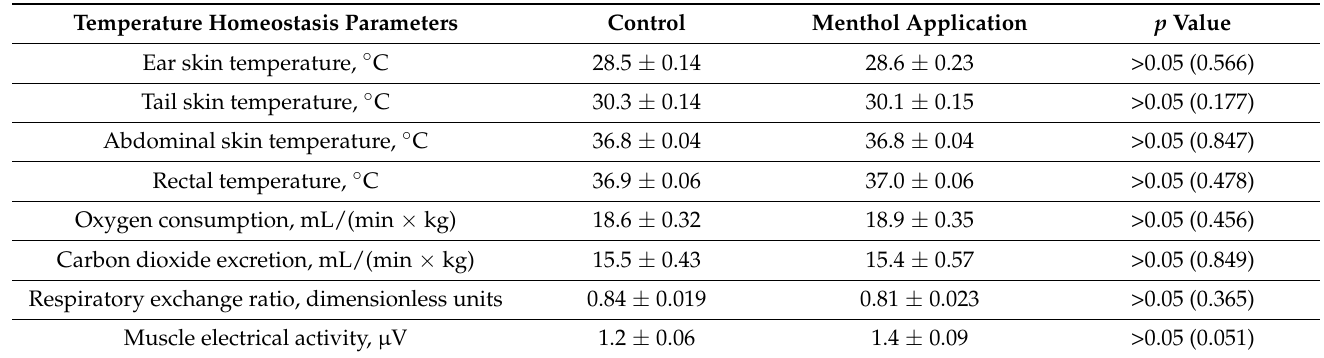
Table 1. Comparison of the temperature homeostasis parameters under thermoneutral conditions